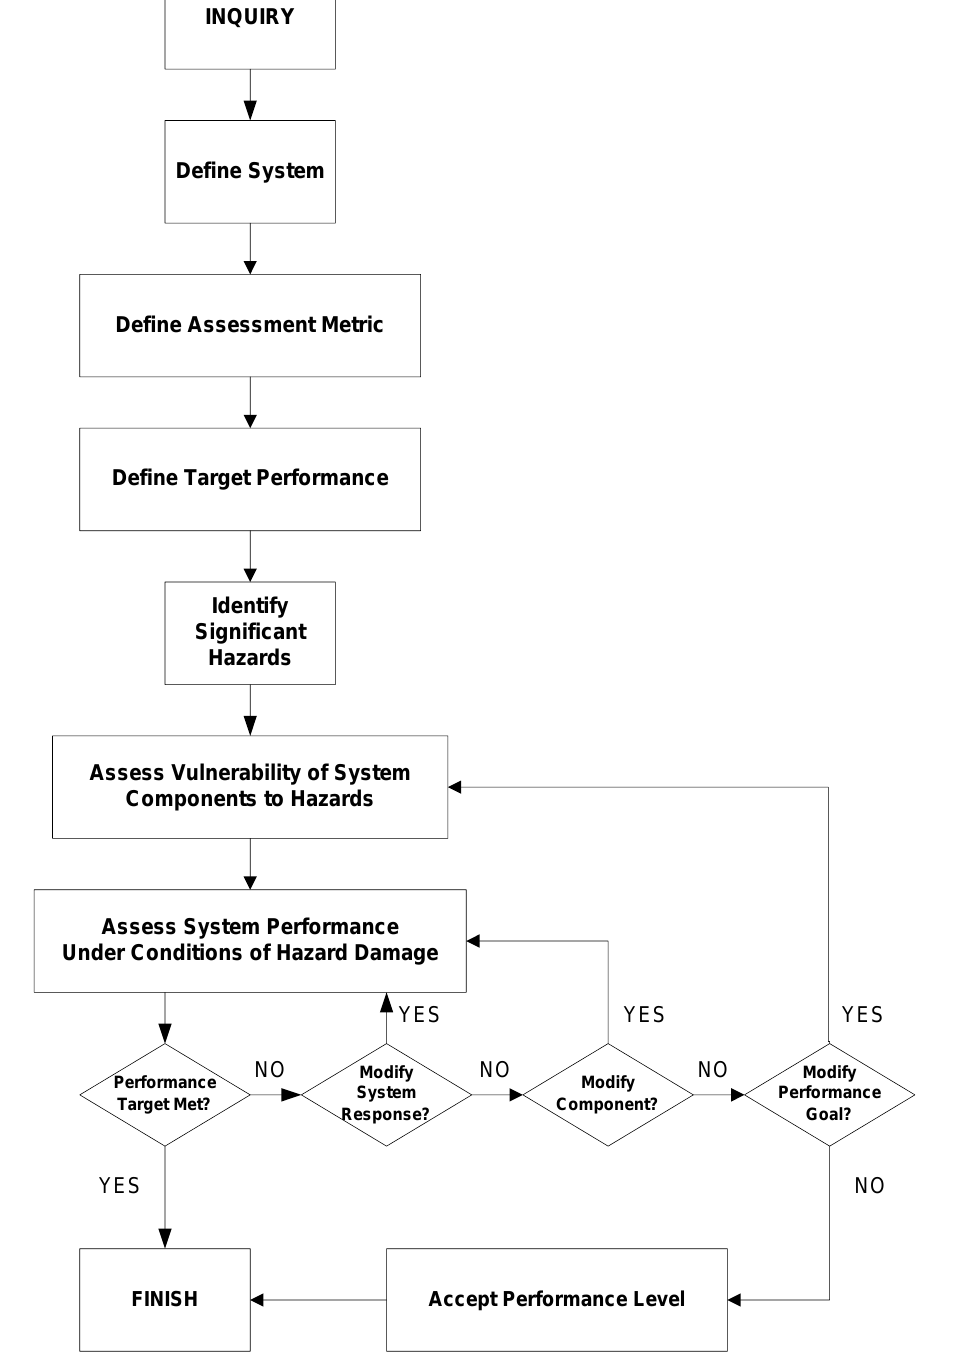
Figure 3. Decision-making Process for Assuring System Performance Goals Are Met (ALA,